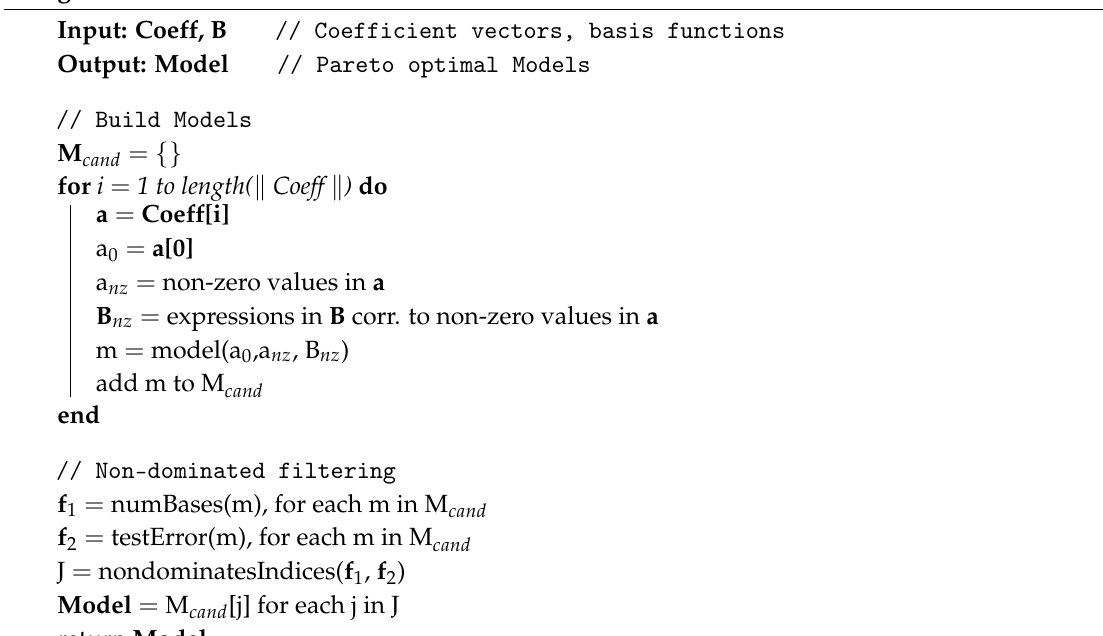
Algorithm 3: Non-dominated